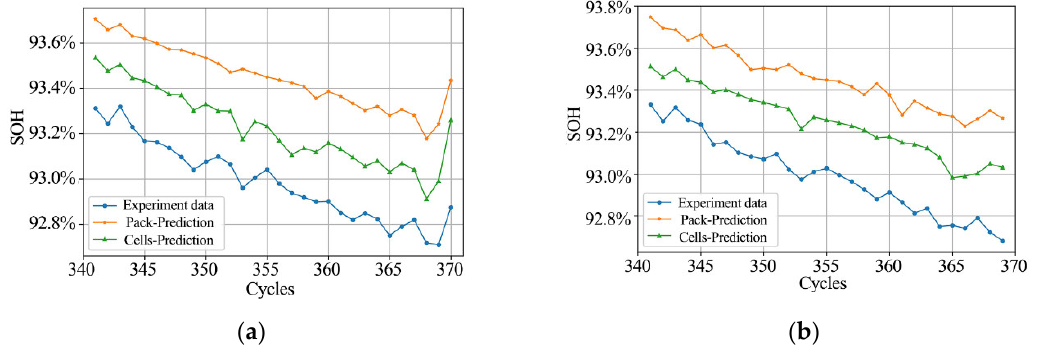
Figure 13. Comparison of the SOH prediction results: ( a ) series; ( b ) parallel.